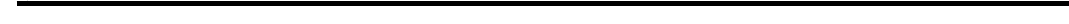
←− Fig. 3–HeartsectionsofBALB/cmiceafter T.cruzi infectionand/orcardiacantigenimmunization. A. Focalanddiscreteinflammatory infiltration by mononuclear cells 30 days after infection with low virulence T. cruzi Y strain clone (100 parasites). B. Inflammatory mononuclear infiltration with myocytolytic lesions, incipient fibrosis and absence of parasites in a cardiac antigen-hiperimmunized mouse 30 days after infection with T. cruzi Y strain clone (100 parasites). C. Myocarditis by mononuclear cells, frequently adhered to myofibers and inducing myocytolysis eight months after infection with T. cruzi Colombian strain (100 parasites). The finding of parasite in this phase of infection is very rare. D. Focal and discrete myocarditis by mononuclear cells in mouse tolerized by injection of a myosin-enriched cardiac fraction eight months after infection with T. cruzi Colombian strain. E. Intense carditis by mononuclear cells with massive destruction of cardiac cells and presence of interstitial fibrosis four months after immunization with myosin-enriched fraction. F. Intense interstitial fibrosis with few remaining intact cardiac fibers and intense inflammatory infiltration by mononuclear cells four months after immunization with a myosin-enriched fraction. A-D. H&E, 400 × . E. H&E, 200 × . F. Masson’s trichrome stain, 400 ×